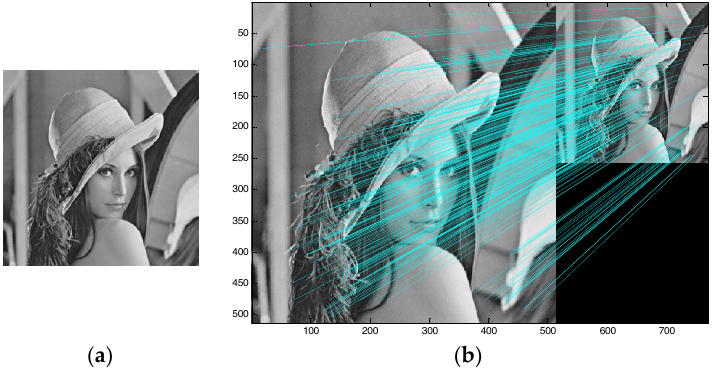
Figure 6. Matching between scaled image and watermarked image: ( a ) scaled image (0.5); ( b ) feature